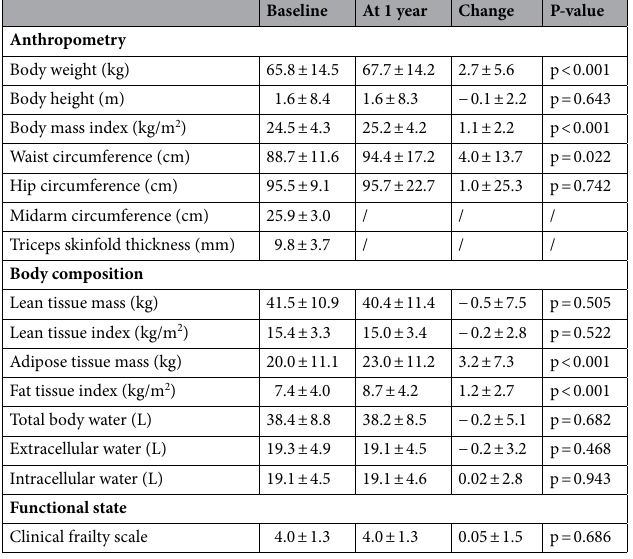
Table 3. Anthropometry, body composition and functional state at baseline and at 1 year. Data are expressed as mean ± standard deviation and compared by Student’s